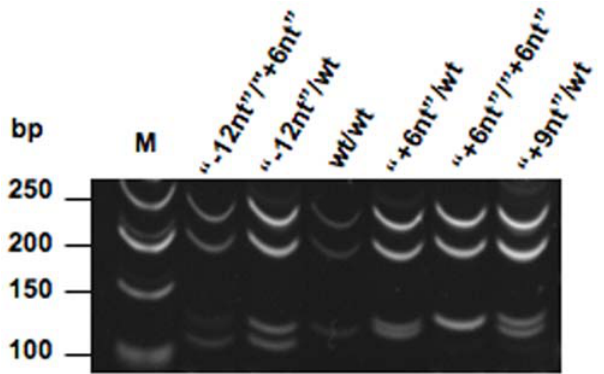
Figure 4. Detection of an Indel variation in the sheep SPRN open reading frame. Samples DNAs were amplified by PCR, digested with Ava I, and run on 15% PAGE gels. Ava I digestion generates 3 fragments: 251 bp, 204 bp, and variable sizes for the smaller fragments, corresponding to 118, 130, 136 and 139 bp respectively for ‘‘ 2 12nt’’, wild type, ‘‘ + 6nt’’ and ‘‘ + 9nt’’ allelic variants. M: Molecular weight marker.